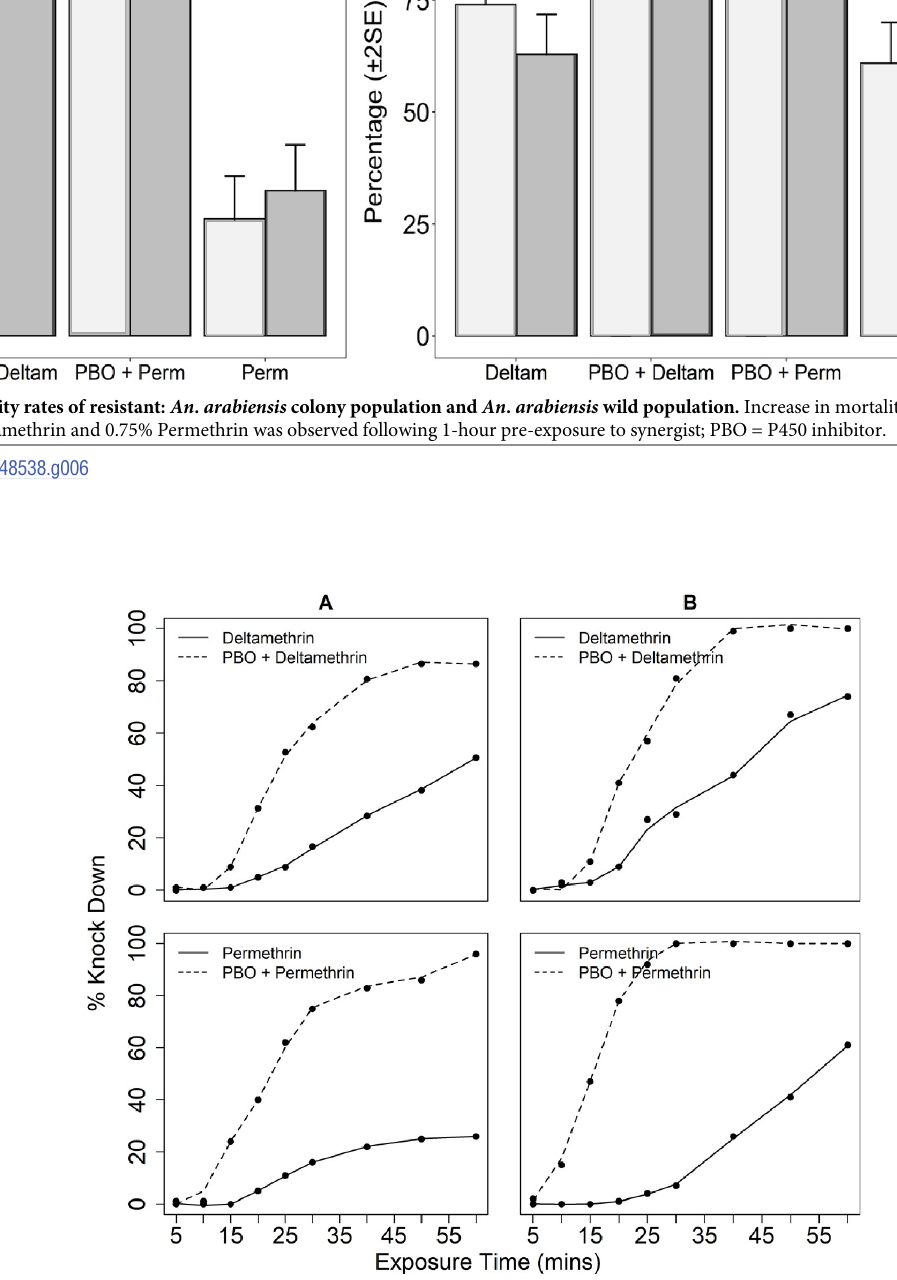
PLOS ONE | https://doi.org/10.1371/journal.pone.0248538 March 18, 2021 12 /